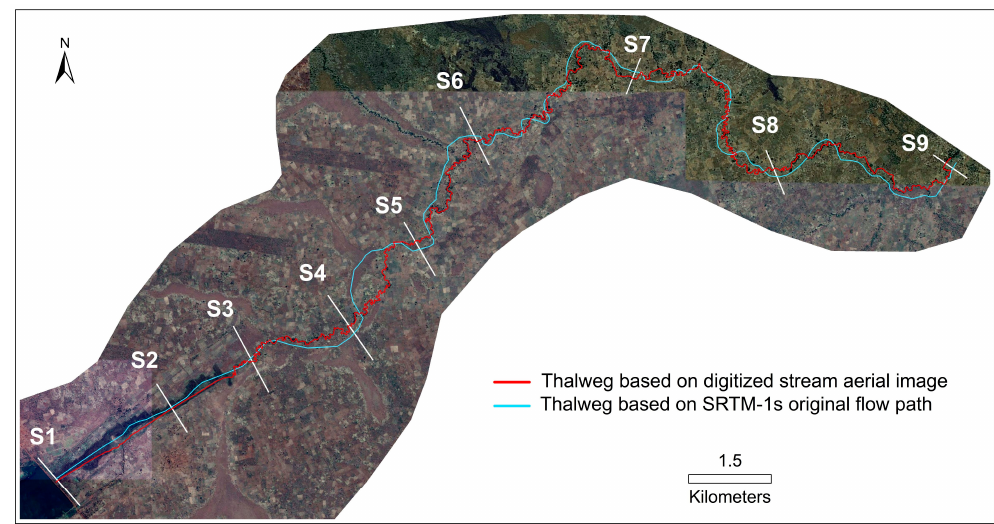
Figure 3. Location of the thalweg based on the aerial image and the original SRTM data, and the locations of the control cross sections.